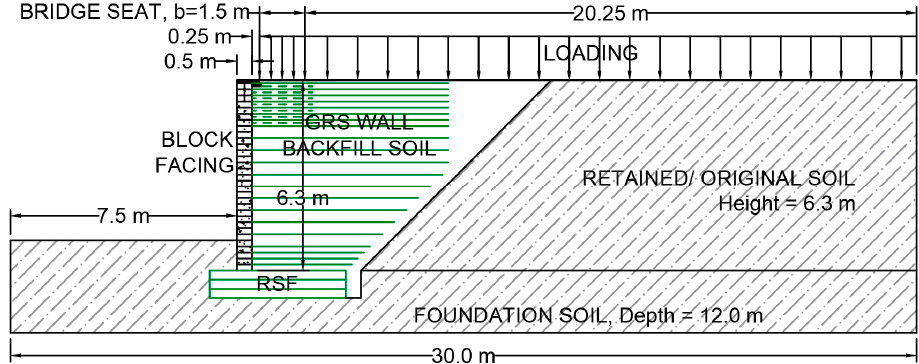
Figure 5. Plaxis 2D numerical model configuration for GRS-IBS (Case 2).